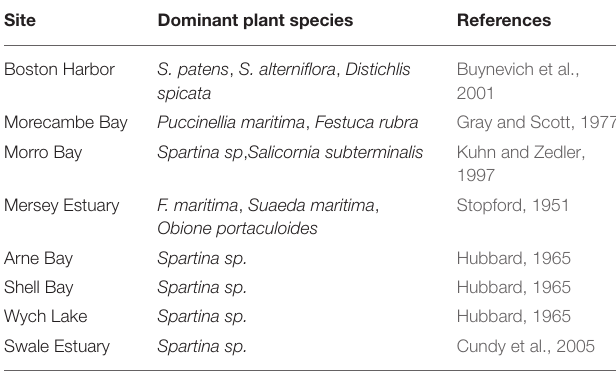
TABLE 1 | Dominant plant species for the selected sites, sourced from literature on regional marsh systems and analog marshes.